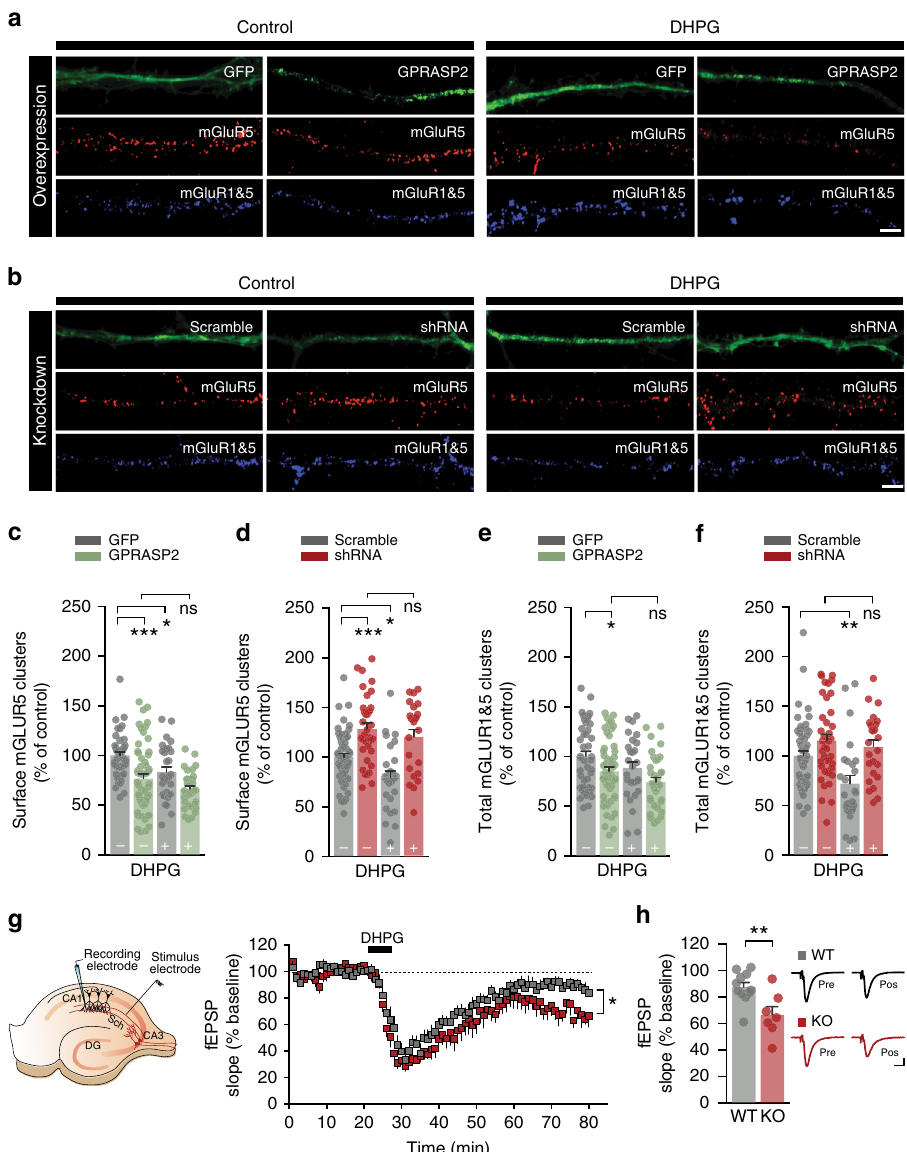
Fig. 6 Bidirectional regulation of mGluR 5 surface availability and enhanced mGluR-LTD in Gprasp2 − /y mice. a , b Representative images from hippocampal neurons transfected with either GFP/GFP-GPRASP2 ( a ) or scramble/shRNA ( b ) in presence or absence of DHPG. Scale bar, 2 µ m. c , d Reduced surface mGluR 5 clusters are observed following overexpression of GPRASP2 ( c ), while there is an increased in surface mGluR 5 clusters in GPRASP2 knockdown conditions ( d ), compared with control cells, with or without the effect of DHPG. e , f Reduced total mGluR 1/5 clusters under overexpression of GPRASP2 ( e ) and increased total mGluR 1/5 clusters in GPRASP2 knockdown conditions ( f ) when compared with control cells, with or without the effect of DHPG. Results are expressed as % of control cells for GPRASP2 overexpression vs GFP (control) or shRNA vs scramble (control); n = 21 – 45 per condition from four independent preparations; one-way ANOVA test with Sidak´s post hoc test. g Schematic diagram of position of the stimulating and recording electrodes in the CA3-CA1 Schaffer collaterals circuit. When compared with WT littermates, Gprasp2 − /y mice display enhanced mGluR-dependent LTD upon DHPG stimulation; WT n = 11/7 slices/mice, KO n = 7/7 slices/mice; two-way repeated measures ANOVA. h fEPSP slope in the last 5 min of the recording post- DHPG stimulation; WT n = 11/7 slices/mice, KO n = 7/7 slices/mice; two-tailed t -test. Scale bar, 0.2 mV, 20 ms. All data are presented as mean ± s.e.m. Statistical signi fi cance: * p < 0.05, ** p < 0.01 and *** p <